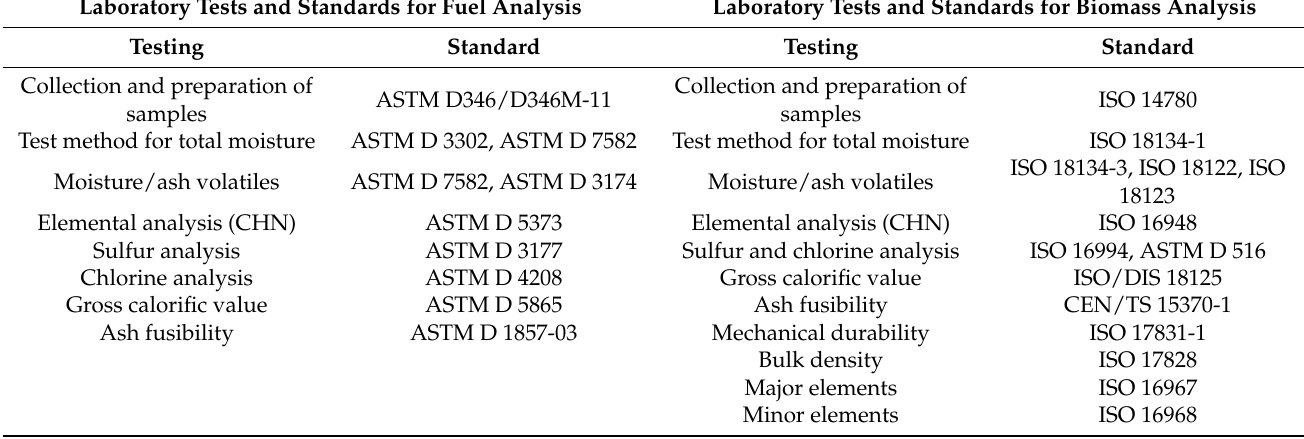
Table 1. Laboratory tests and